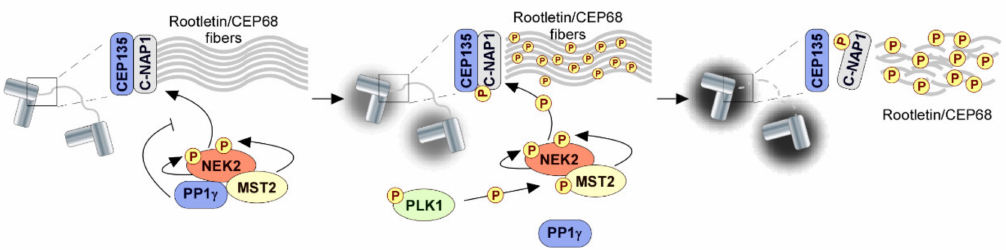
Figure 5. PP1 prevents premature separation of centrosomes. Centrosome splitting during late G2 involves the dissolution of the Rootletin/CEP68 linker that holds duplicated centrosomes together. This process is orchestrated by NEK2A-mediated phosphorylation of C-Nap1 and of linker proteins. Phosphorylation of C-NAP1 abrogates its interaction with CEP135 docked on the proximal ends of parental centrioles, thus causing C-NAP1 displacement from centrosomes. Phosphorylation of Rootletin and of associated proteins disrupts the linker structure and enables centrosome disjunction. PP1 γ suppresses NEK2A activity up until late G2, thereby preventing premature resolution of centrosomes. During interphase, PP1 γ bound to NEK2A in complex with MST2 is able to efficiently antagonize phosphorylations catalyzed by the kinase. Increasing activity of PLK1 in late G2 results in MST2 phosphorylation and consequential dissociation of PP1 γ from the complex. This renders NEK2A phosphorylations unopposed, hence allowing pre-mitotic resolution of